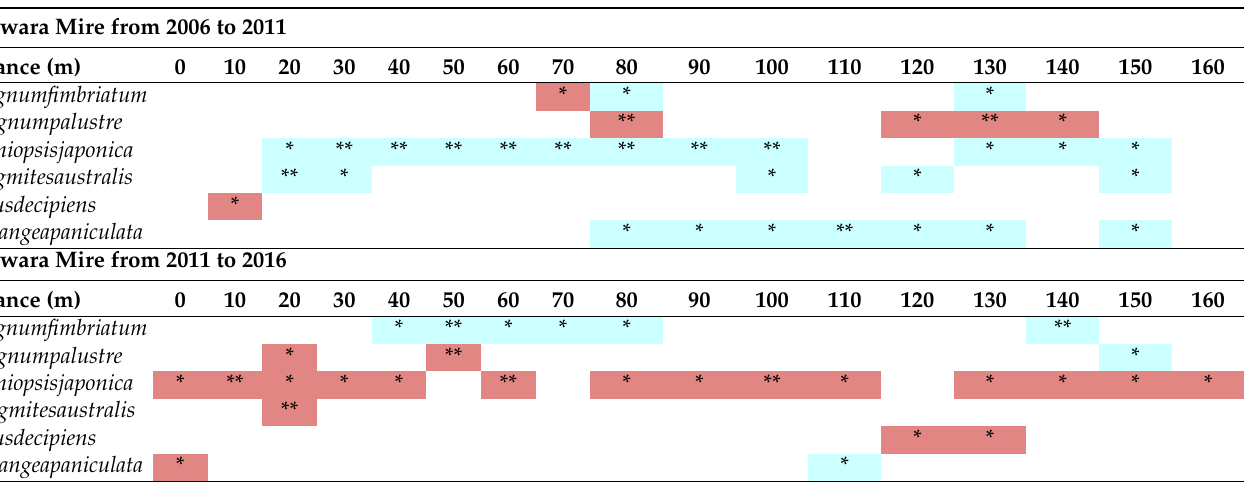
Table 1. Significance levels of difference of coverage of abundant species between 2006 and 2011 and between 2011 and 2016 at water environment monitoring sites along the Tadewara transect (TDW transect). Five 1 × 1 m 2 quadrats of both sides of each water environment monitoring site (one side at both end sites) were assigned to each site. Significance of difference was tested by Wilcoxon test. Red-colored cells show the increase in coverage and blue-colored cells show the decrease in coverage from the beginning to the end of each period.